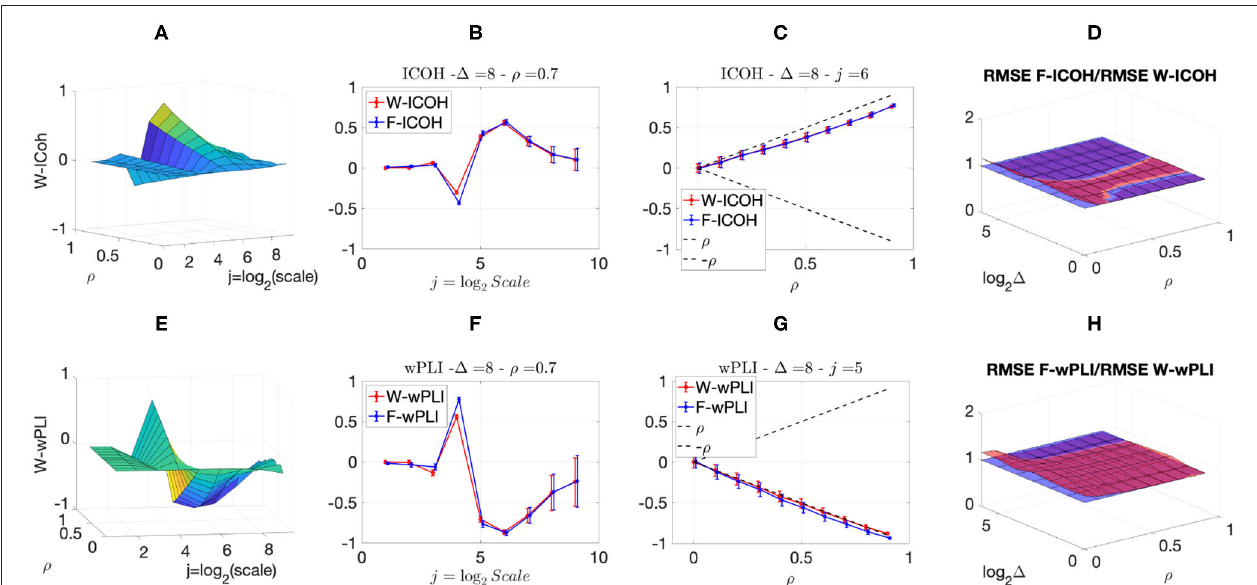
FIGURE 3 | Complex Wavelet-based connectivity on synthetic bivariate fractional Gaussian noise with correlation and delay 1 = 8. Top row: W-ICOH results. Bottom row: W-wPLI results. From left to right: W-ICOH (A) and W-wPLI (E) as functions of octaves j and correlation coefficient ρ ; W-ICOH (B) and W-wPLI (F) as functions of octaves j , for a given ρ ; W-ICOH (C) and W-wPLI (G) as functions of ρ for given octaves j ; Ratio of the RMSE of F-ICOH to W-ICOH (D) and ratio of RMSE of F-wPLI to W-wPLI (H) , averaged across scales 3 ≤ j ≤ 7, and color-coded in red as functions of delay 1 and correlation coefficient ρ . A ratio larger than the value of 1 (made explicit to ease comparisons by horizontal blue plans) indicates poorer performance for Fourier-based estimates compared to wavelet-based ones. Synthetic data consists of bivariate fGn with H 1 = 0.7 and H 2 = 0.8.